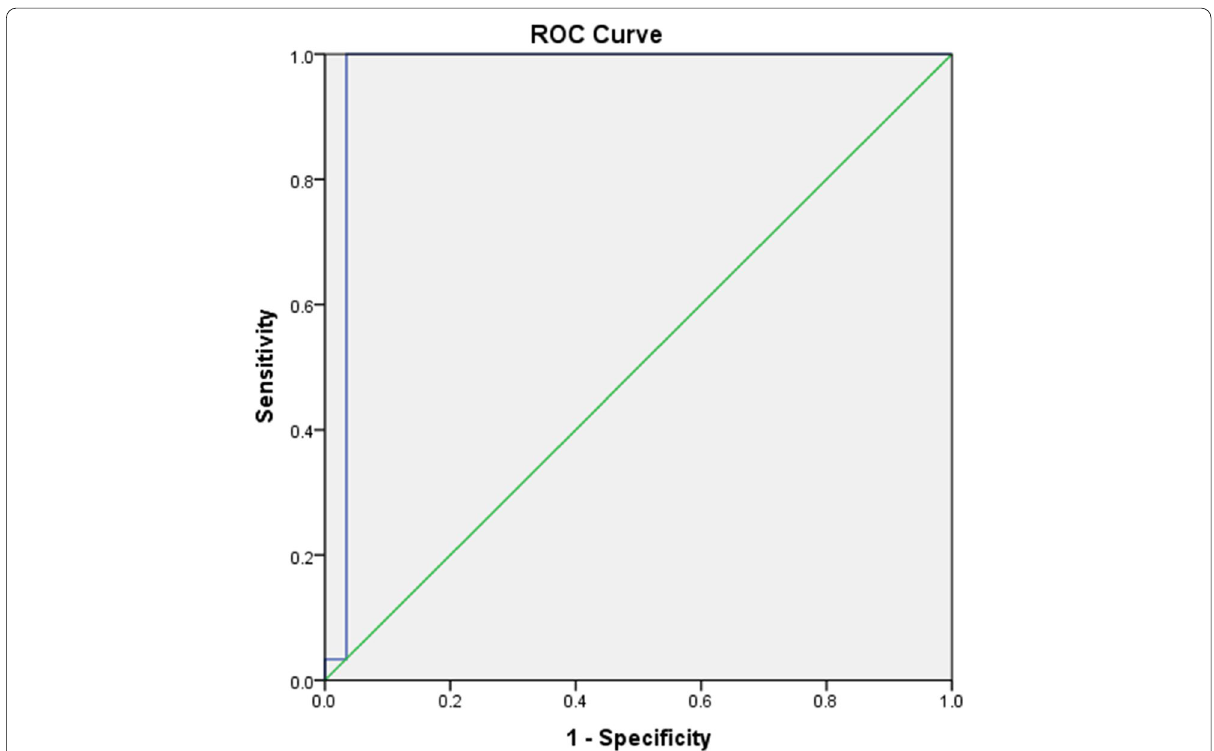
Fig. 3 ROC curve analyses identified nesfatin‑1 levels of 9 ng/dl as cut‑off value for diagnosis of pre‑diabetes with 0.94 for area under curve ≤ (AUC), 96.7% sensitivity, 93.3% specificity, 93.5% positive predictive value (PPV), 96.6% negative predictive value (NPV), and 95% accuracy